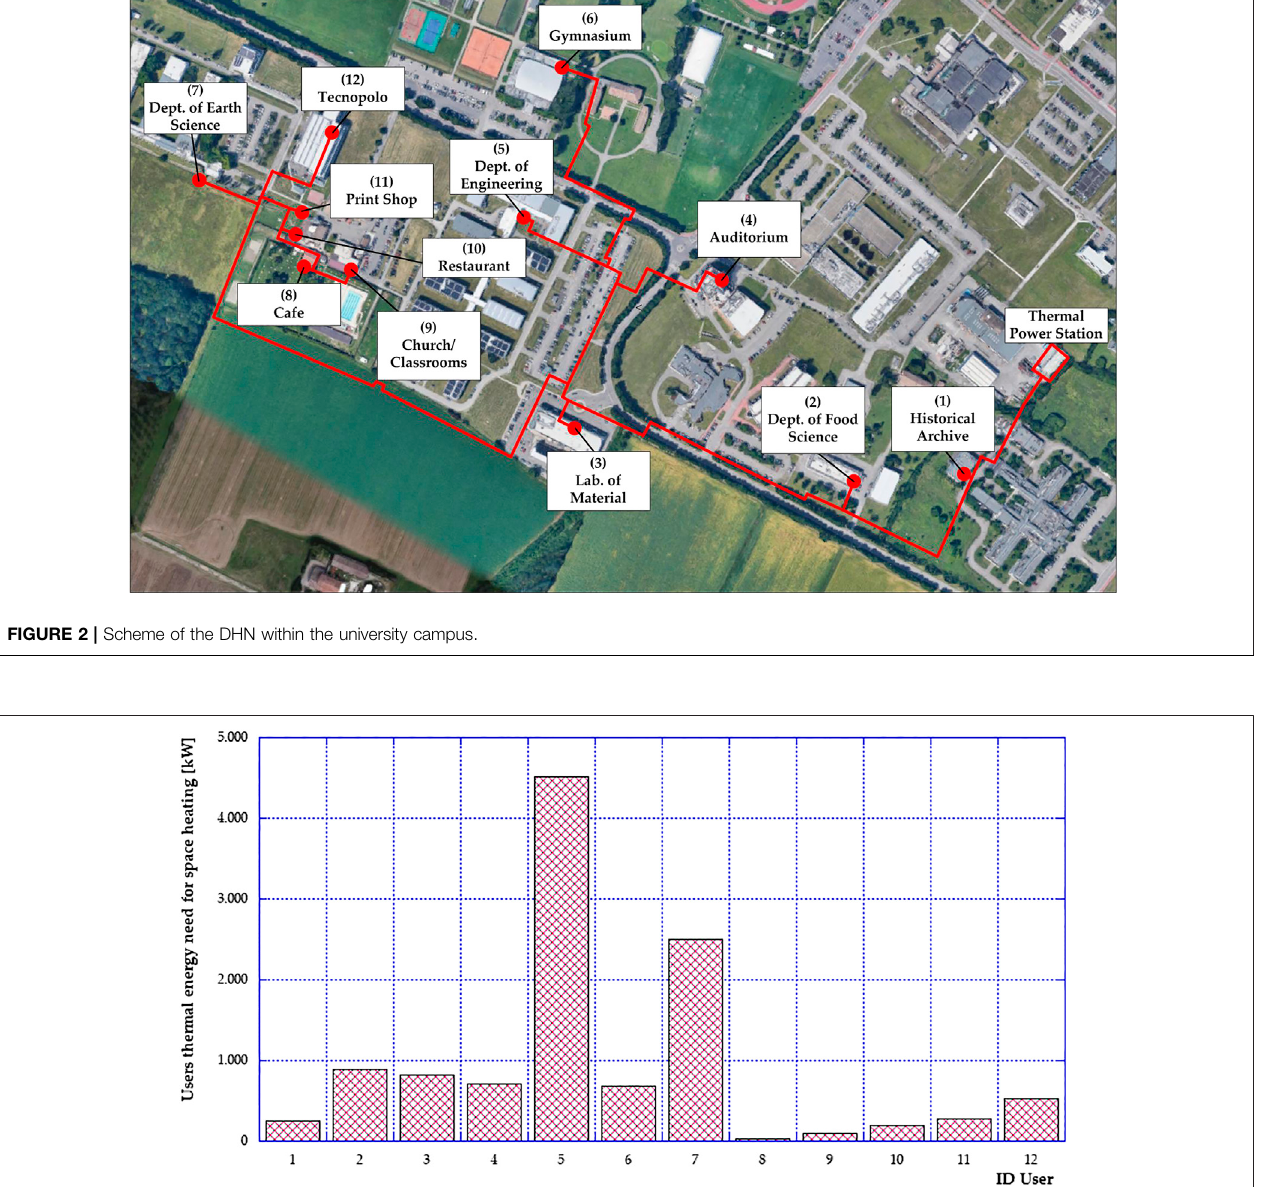
FIGURE 3 | Design of thermal energy needs of the DHN